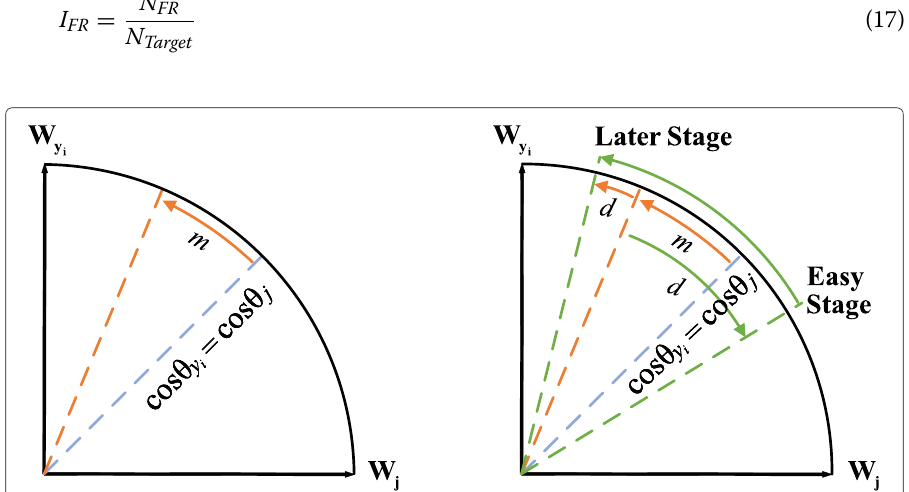
Fig. 4 The blue line, yellow line, and green line are Softmax, AAM-Softmax„ and our decision boundary, respectively. m is the feature margin of AAM-Softmax. d is adaptive feature margin